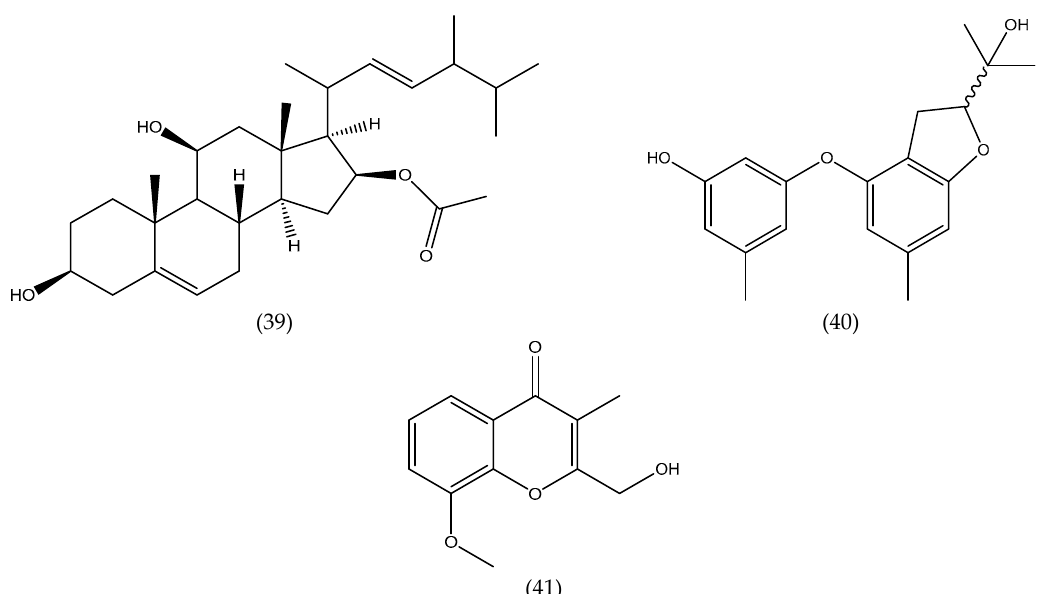
Figure 1. Chemical structures of natural products isolated from seaweed derived-endophytic fungi with antitumor potential published from 2009 to 2019.